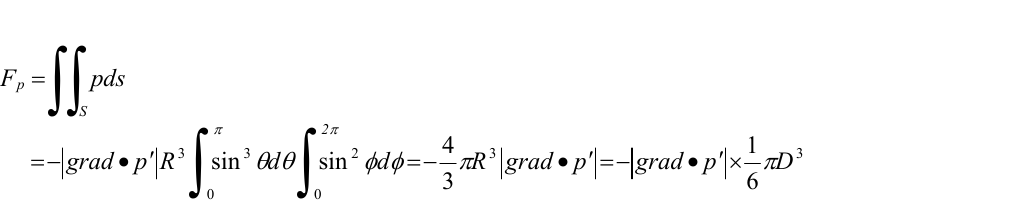
Fig. 5 Schematic of particle exposed to instantaneous pressure field with pgrad